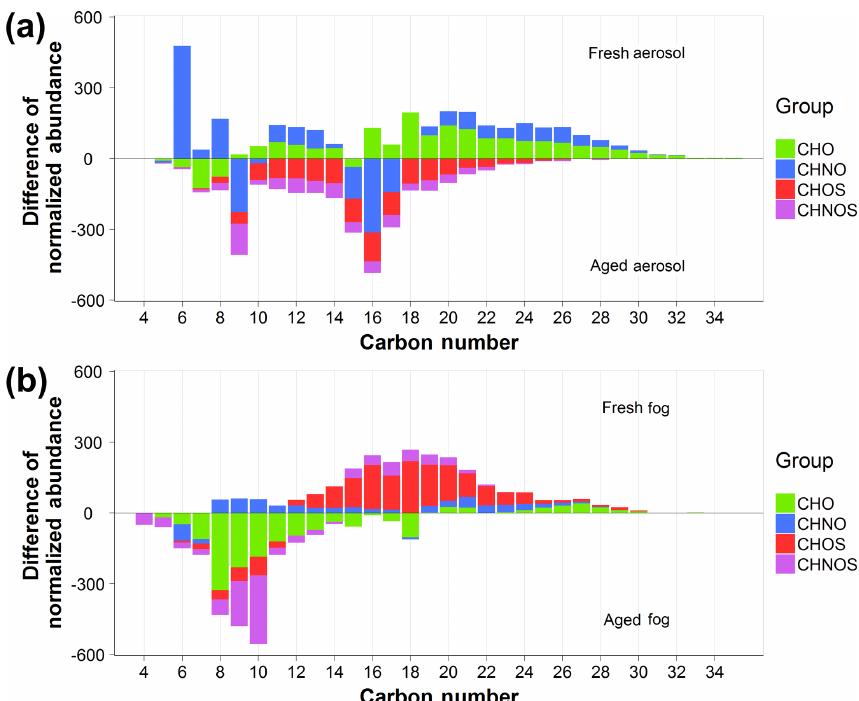
Figure 7. Carbon difference trend plots for aerosol (a) and fog (b) sample types. Difference trends were calculated as in Fig. 6, and then the respective aged sample was subtracted from the fresh sample for each integer carbon number value. Positive values indicate an enhanced abundance of the formulas in the fresh sample compared to the aged sample. Similarly, negative values indicate an enhanced abundance of formulas in the aged sample compared to the fresh sample. The sample names fresh fog, aged fog, fresh aerosol, and aged aerosol correspond to SPC0106F, SPC0201F, BO0204N, and BO0213D,